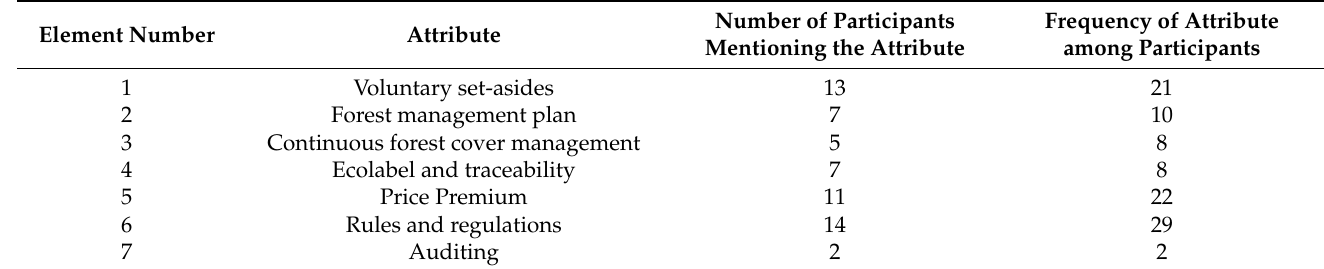
Table 4. Frequency of attributes mentioned in interviews with